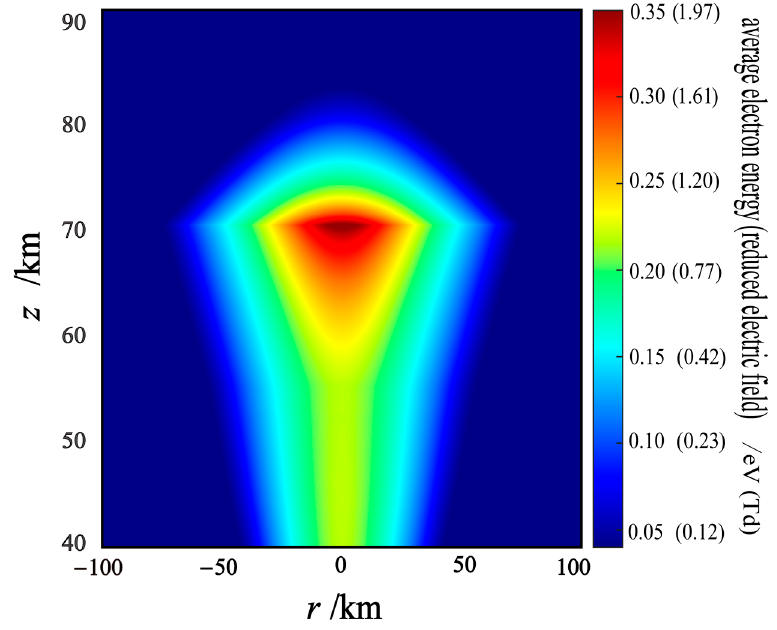
Figure 8. Electron energy (reduced electric field E/N) in the lower ionosphere under the action of a 100 C monopolar thundercloud electric charge located at 10